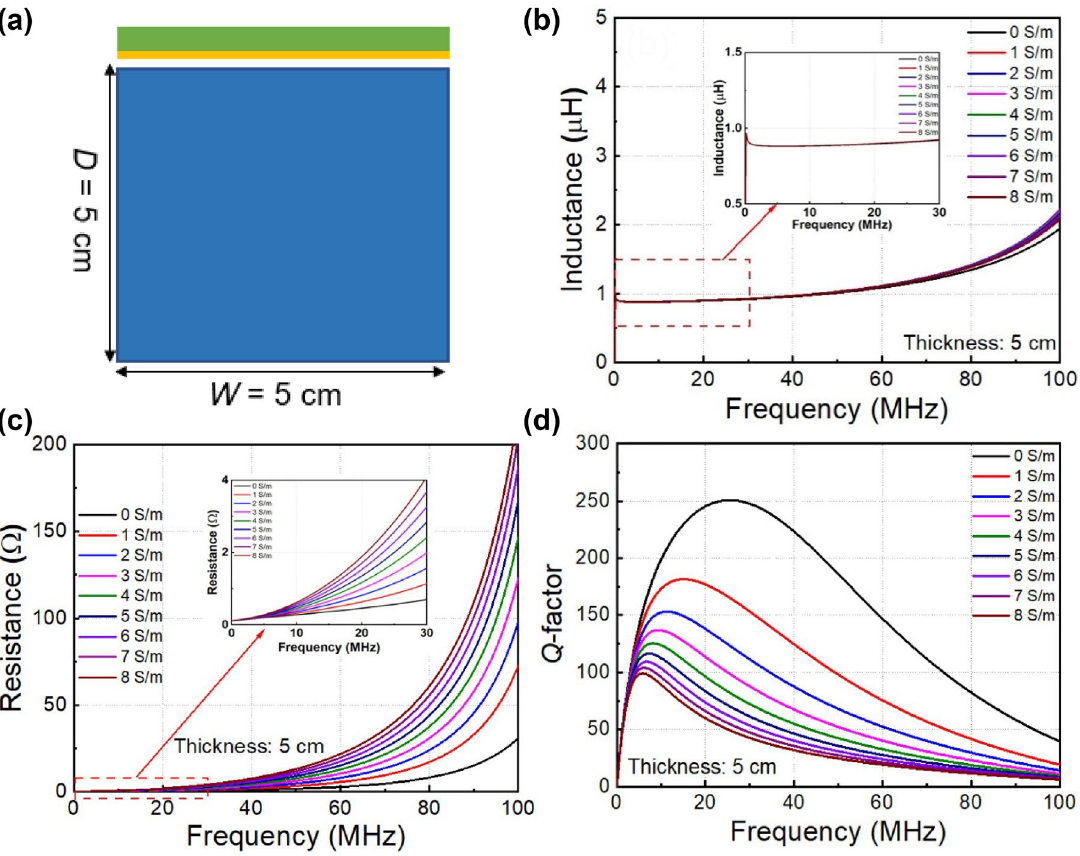
Figure 4. Resonator coil parameters as a function of frequency at various conductivities, (a) schematic view of the simulation setup, (b) inductance, (c) resistance, (d) quality